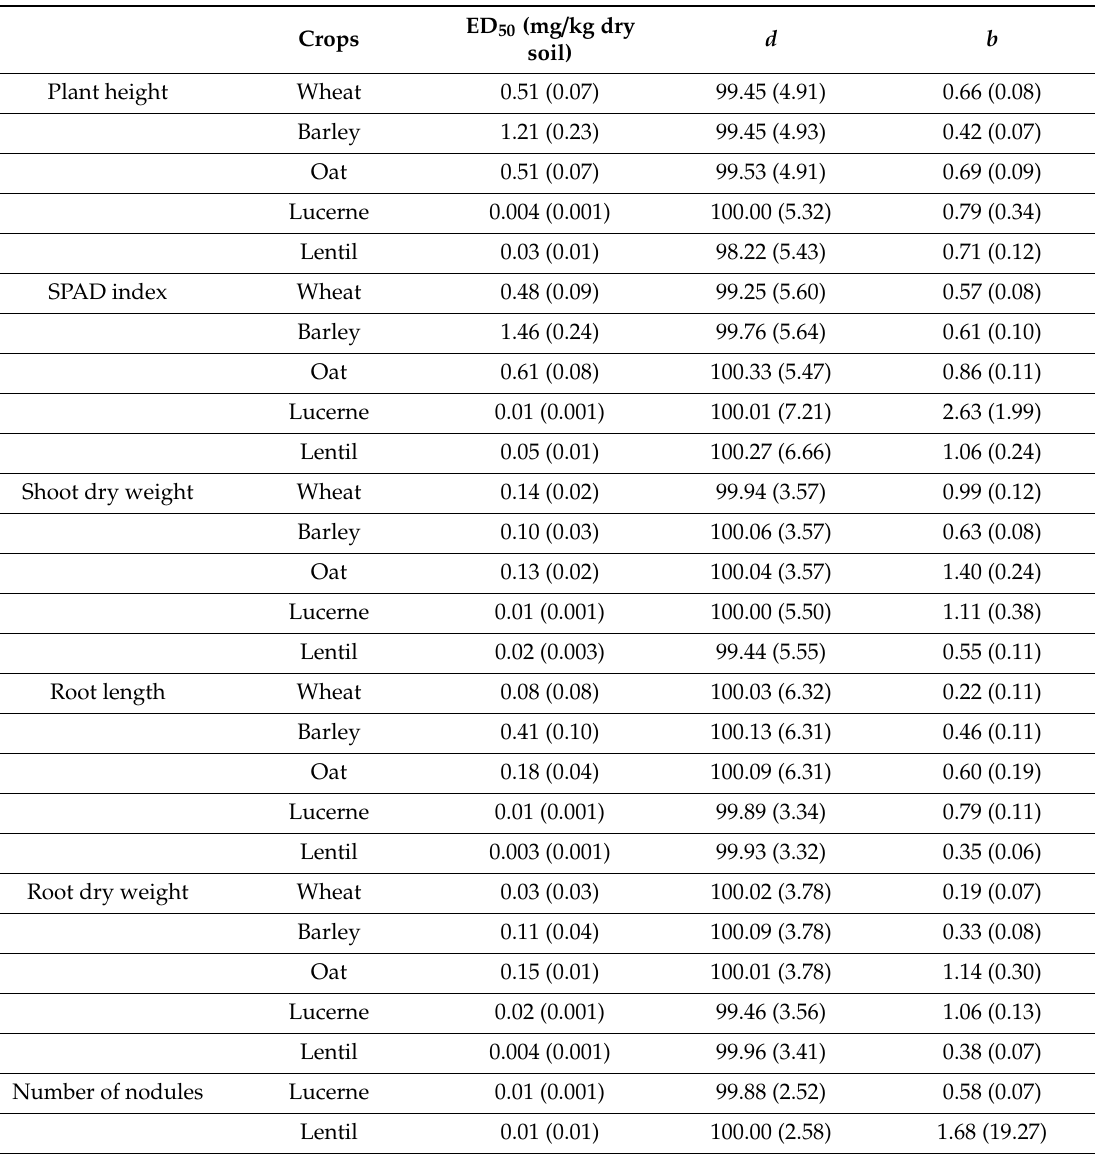
Table 2. Estimated regression parameters of the four parameter Weibull model (Weibull1) and four parameter log-logistic model for the shoot and root parameters of wheat, barley, oat, lucerne and lentil against various levels of atrazine concentrations as per Equations (2) and (3) mentioned in materials and methods